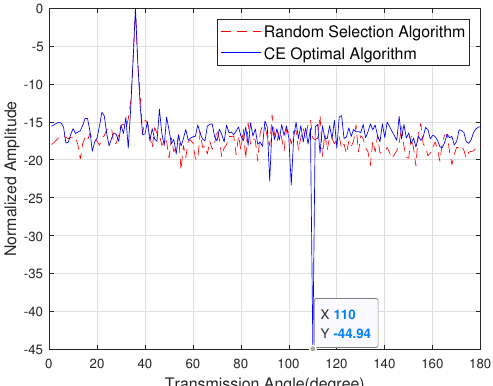
Figure 6. The sidelobe energy of the emission pattern with the known channel state information of the